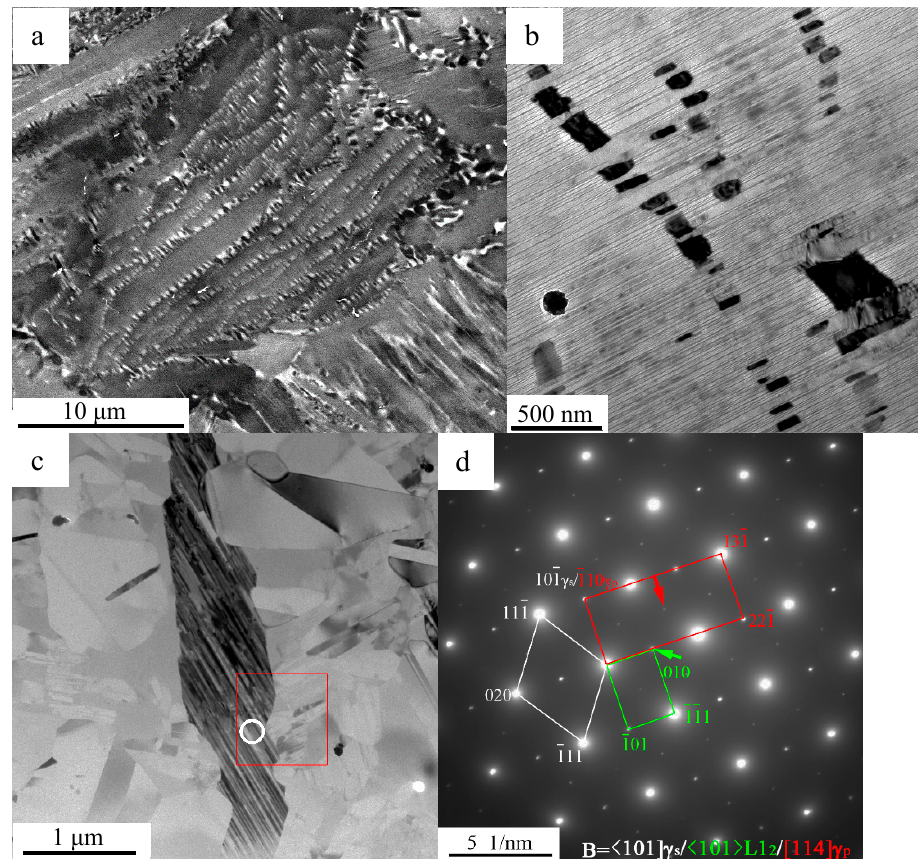
Figure 3. ( a ) SEM—BSE and ( b , c ) TEM images of the microstructures annealed at 850 °C for 5 h; ( d ) SADPs of the white circle in ( c ) with B = <101] γ s . The red rectangle in ( d ) represent the calibration of the γ p phase and the green rectangle represent the calibration of the L1 2 phase.